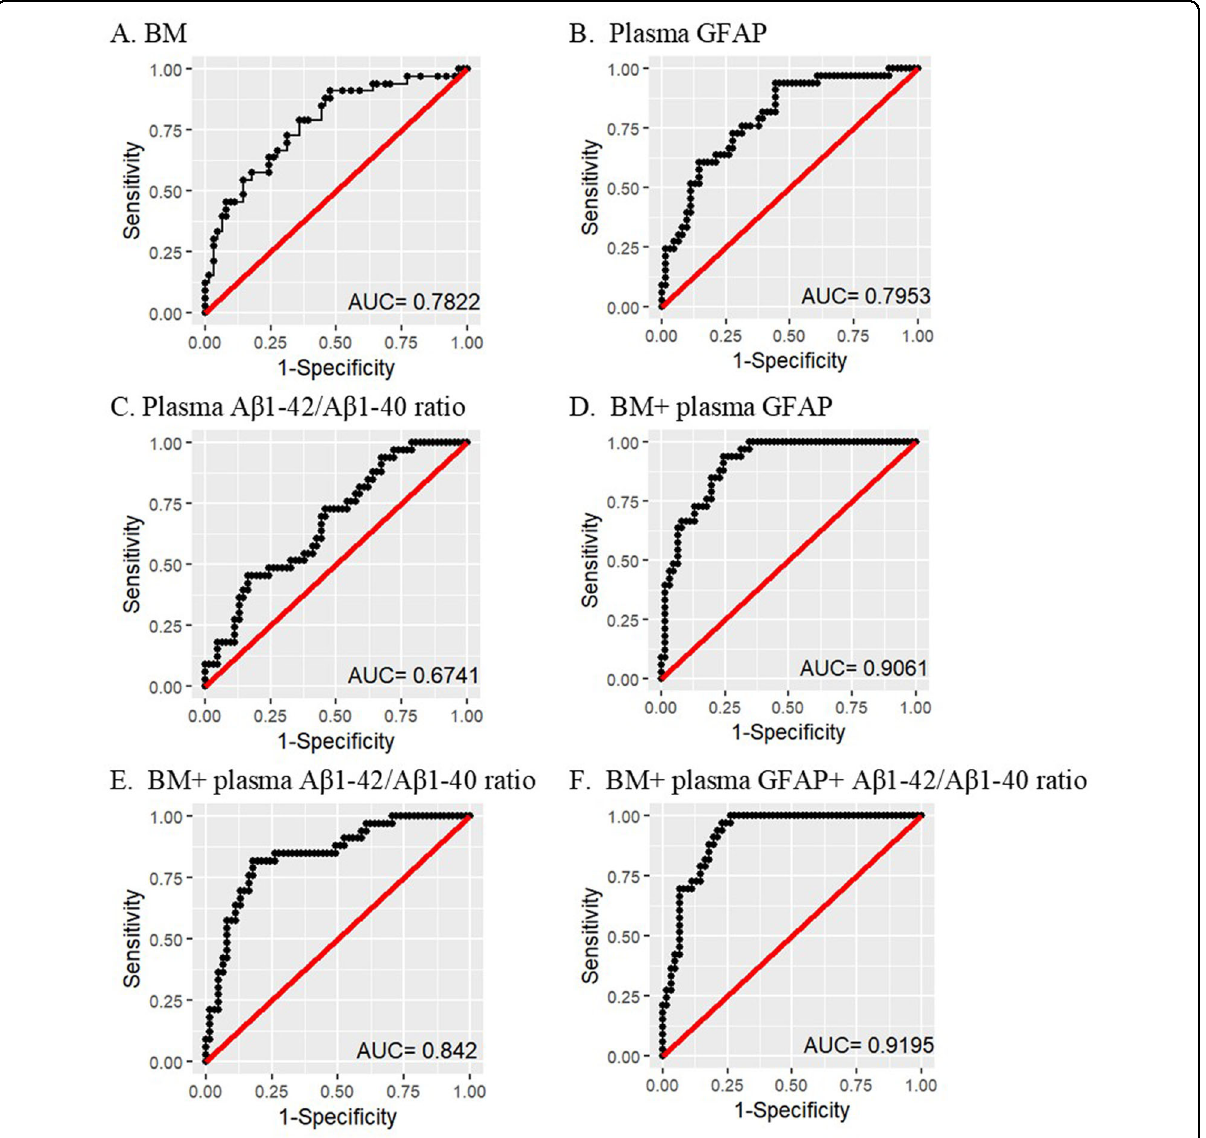
Fig. 2 Receiver operating characteristic curves for the prediction of A β + versus A β − participants. Receiver operating characteristic (ROC) curves are presented for A the ‘ base ’ model (BM) comprising major risk factors age, sex, and APOE ε 4 allele status (CI = 0.684 – 0.880), B plasma GFAP (CI = 0.703 – 0.888), C plasma A β 1 – 42/A β 1 – 40 ratio (CI = 0.563 – 0.785), D BM + GFAP (CI = 0.849 – 0.964), E BM + plasma A β 1 – 42/A β 1 – 40 ratio (CI = 0.758 – 0.926), and F BM + GFAP + plasma A β 1 – 42/A β 1 – 40 ratio (CI = 0.867 – 0.972). The base model was outperformed by models B , D – F . Logistic regression models were employed to perform the analyses. Data from 94 participants were utilised for the analyses (A β − , n = 61; A β + , n = 33). GFAP glial fi brillary acidic protein, AUC area under the curve, CI con fi dence